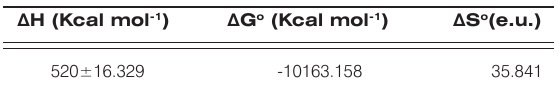
Table 1. Enthalpic and entropic changes for the ASPM partitioning in